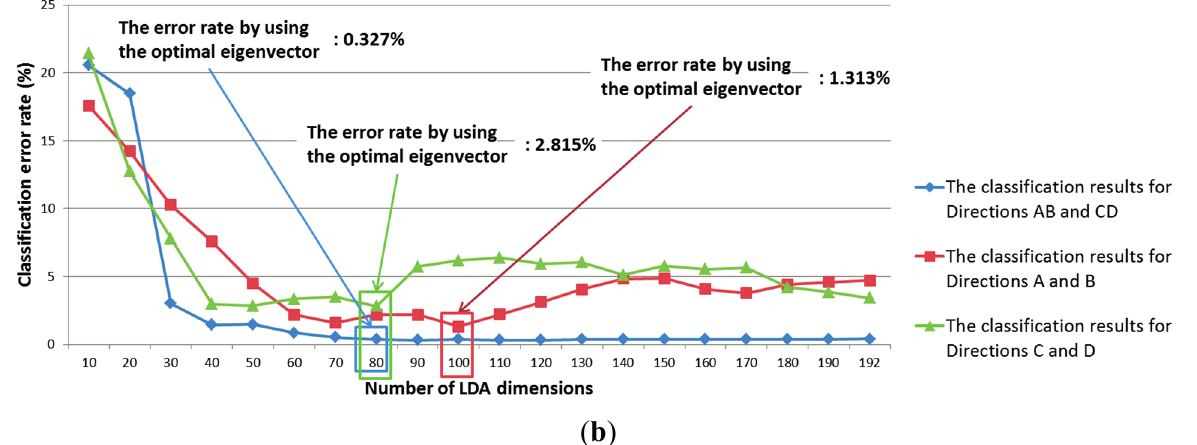
Figure 6. Classification accuracy of LDA according to number of LDA dimensions: ( a ) Group 1; ( b ) Group 2.